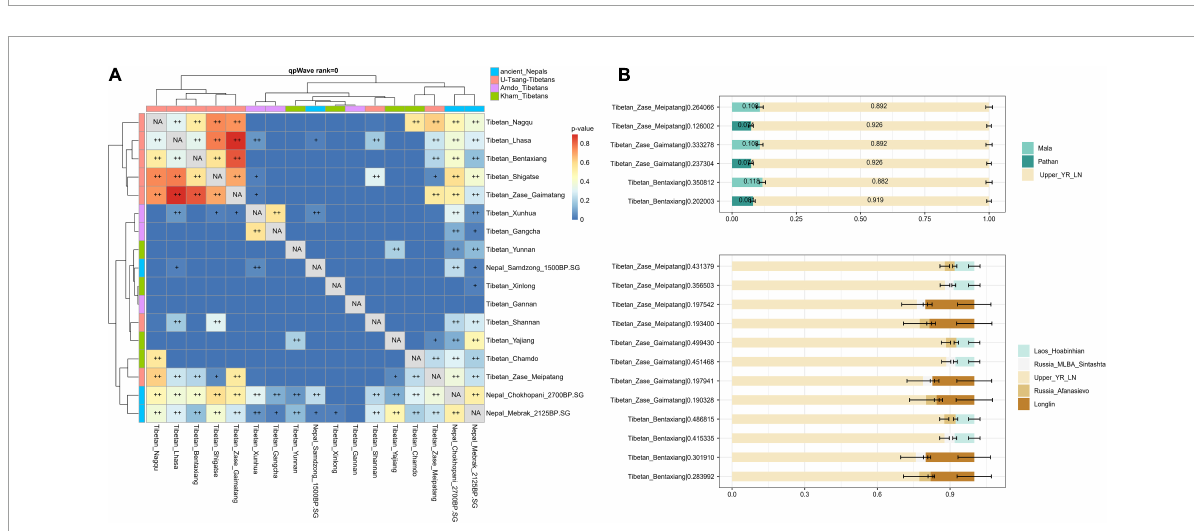
FIGURE4 Inferring the demographic history of our studied Nagqu Tibetans. (A) Pairwise qpWave analysis suggested the genetic homogeny between the studied Nagqu Tibetans and ancient Nepalese from Chokhopani and Mebrak-related cultures as well as published present-day Tibetan populations from Nagqu, Lhasa, and Shigatse (0.01 < p -value < 0.05 was noted as +, p -value > 0.05 was noted as ++) and (B) the fitted two-way and three-way qpAdm-based admixture model for three studied Nagqu Tibetan populations. For each target population, we reported the p -value for rank = 1 behind the corresponding population name in the form of “population name| p -value.” The error bars showed the standard errors of the estimated ancestry proportions. Details of the modeling are provided in Supplementary Table 8